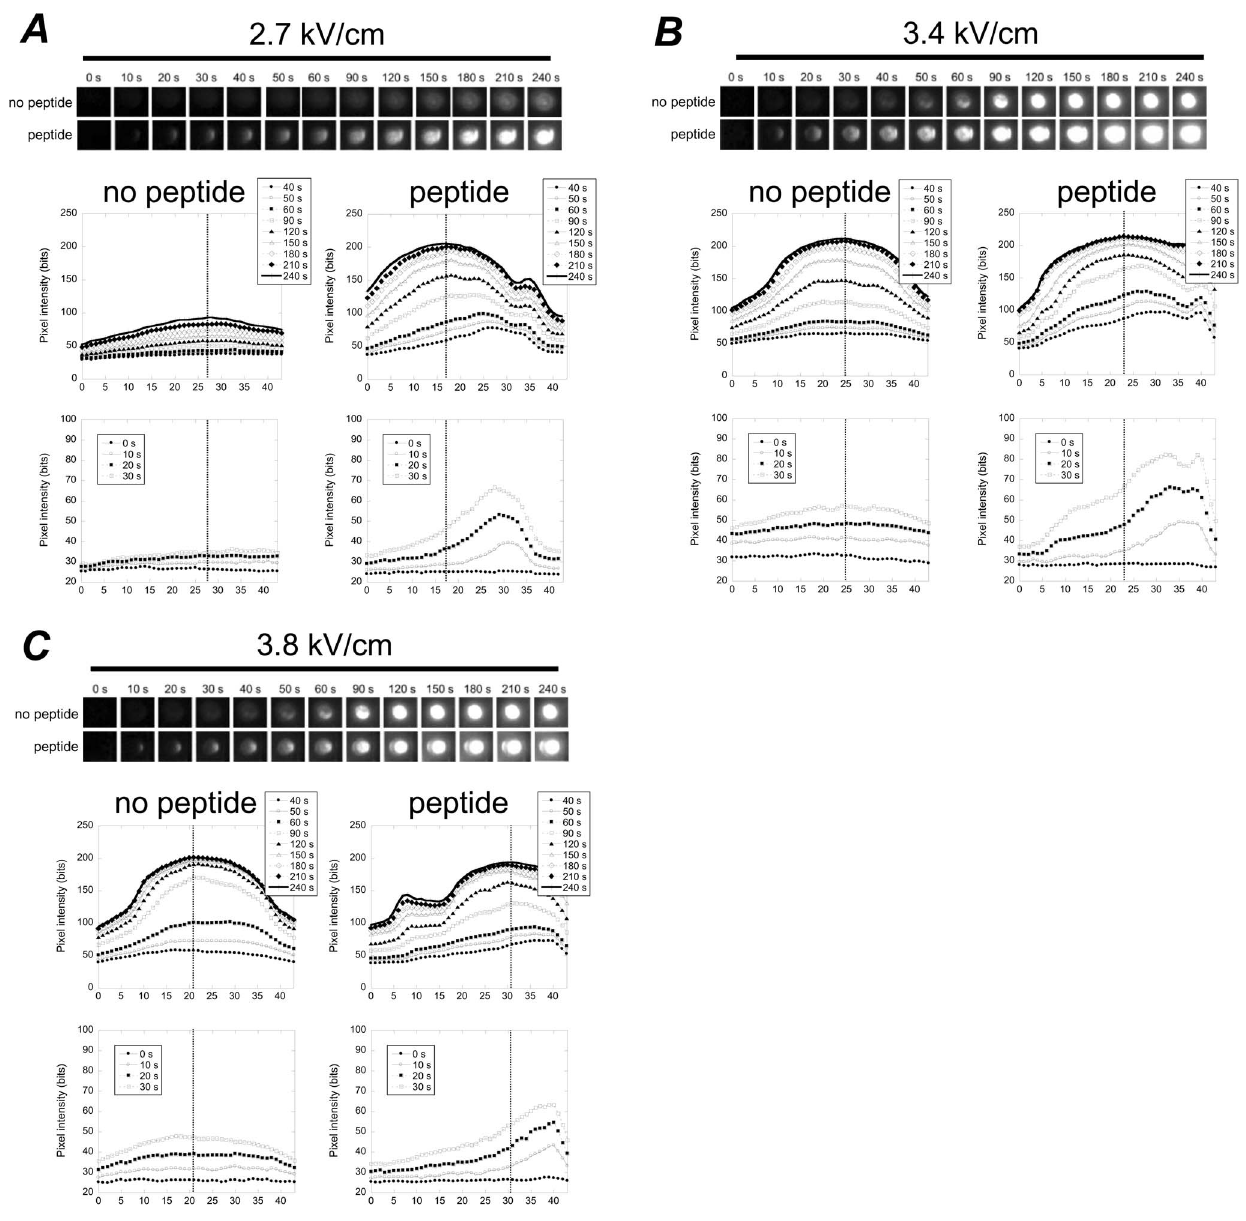
Figure 10. Experiments confirmed that cationic peptide exposure results in PI internalization, preferentially through the anode- facing membrane, particularly at time points immediately following PEF administration. Examples at 2.7 kV/cm ( A ), 3.4 kV/cm ( B ), and 3.8 kV/cm ( C ), comparing real time fluorescence images during experiments revealed that cationic-peptide-exposed cells internalize PI asymmetrically (bottom fluorescence microscopy sequences, anode is at left) and non-peptide-exposed cells internalize PI symmetrically (top image sequences). This anodally preferenced PI uptake was most apparent at earlier time points (bottom graphs in each subfigure of the spatial distribution in PI fluorescence across the cellular axis). Top graphs in each subfigure show PI fluorescence axial distributions at later time points (40– 240 seconds). The vertical line in each graph represents the point of maximum fluorescence at 240 seconds and is intended to estimate the cell center line. In each image and graph, the anode is at